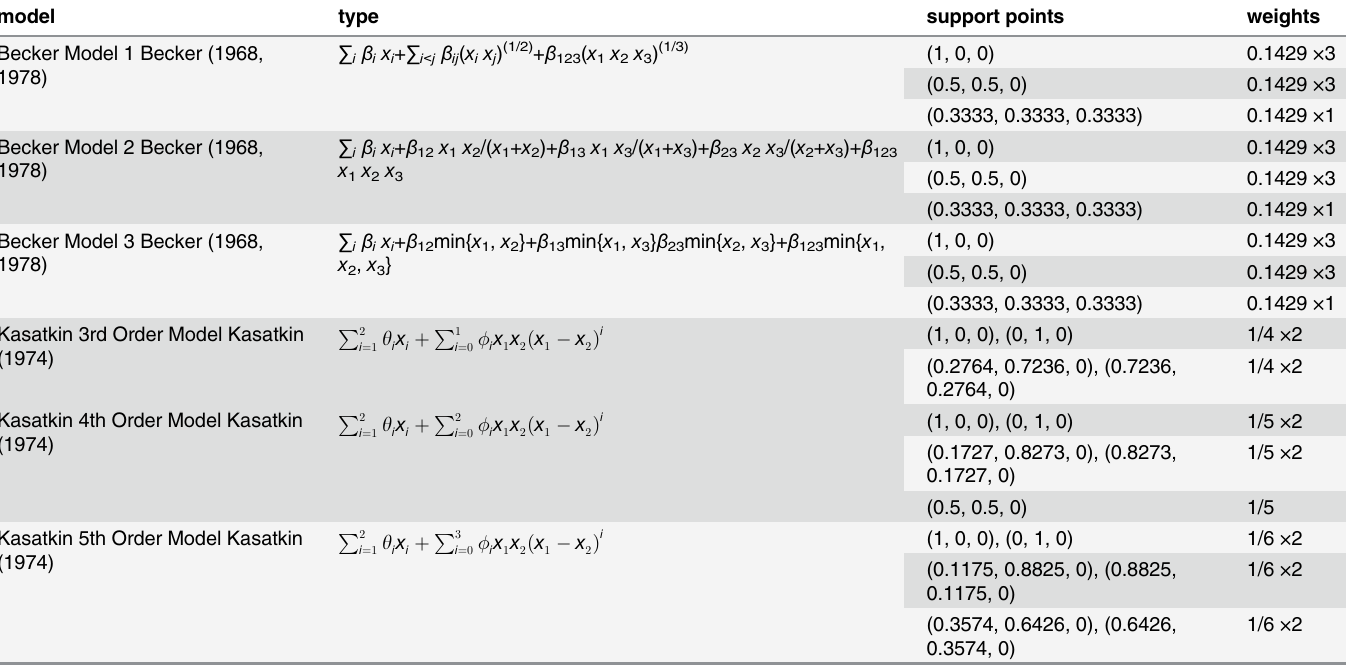
Table 2. ProjPSO-generated D -optimal designs for Becker and Kasatkin ’ s mixture models with 3 factors.